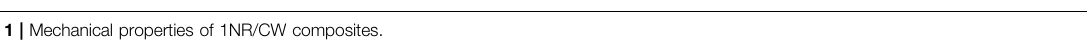
TABLE 1 | Mechanical properties of 1NR/CW composites. Sample